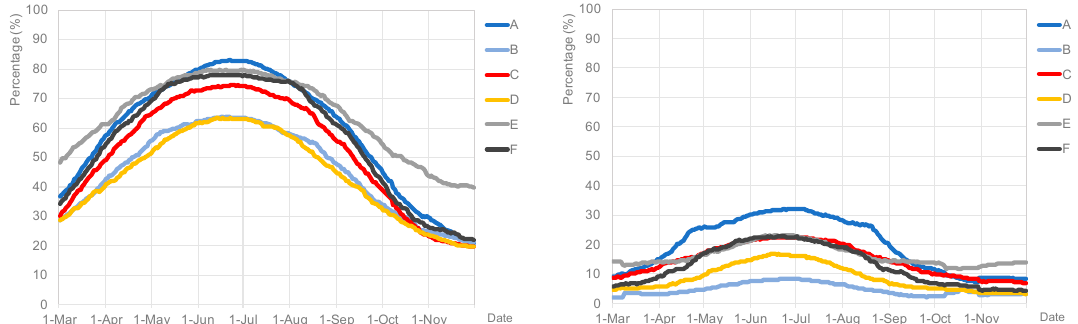
Figure 9. Percentages of ground-level surface with direct sunlight for three or more hours ( left ) and six or more hours ( right ) from March to November for study sites A to F when FAR is 3.0.